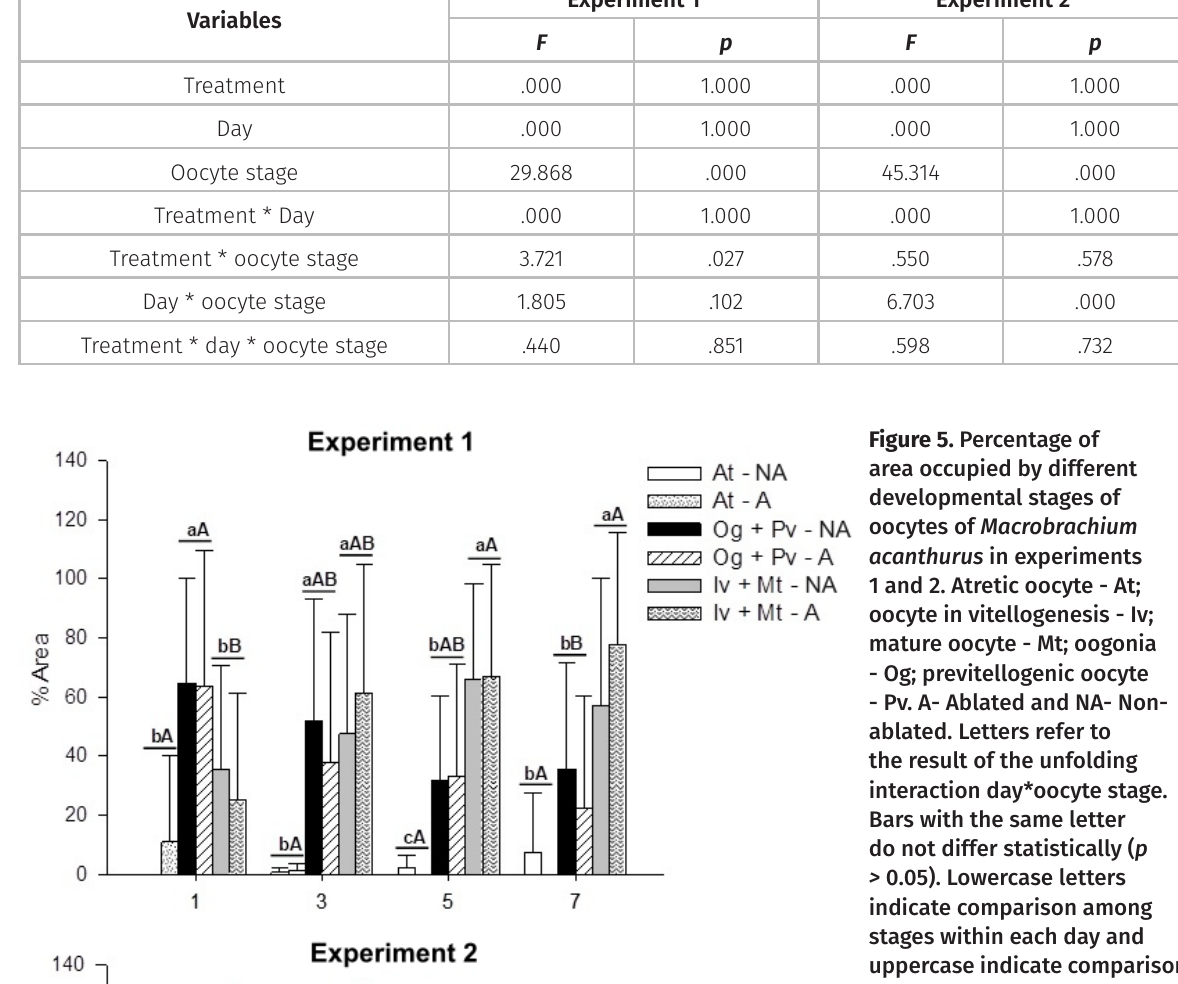
ablated. Letters refer to the result of the unfolding interaction day*oocyte stage. Bars with the same letter do not differ statistically ( p > 0.05). Lowercase letters indicate comparison among stages within each day and uppercase indicate comparison of each stage among